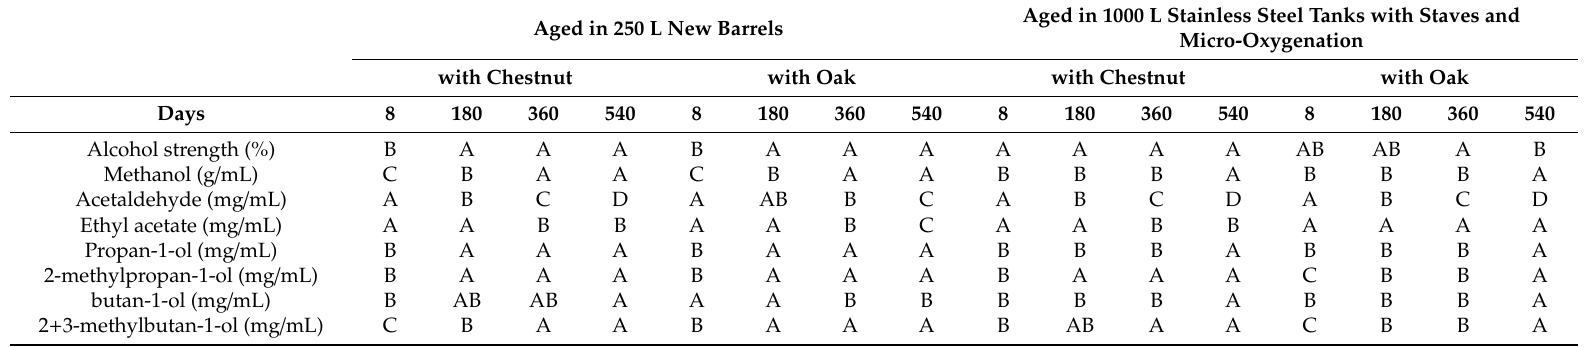
Table 3. Di ff erences observed for each sample group (technology vs. wood) during the ageing time. Aged in 250 L New